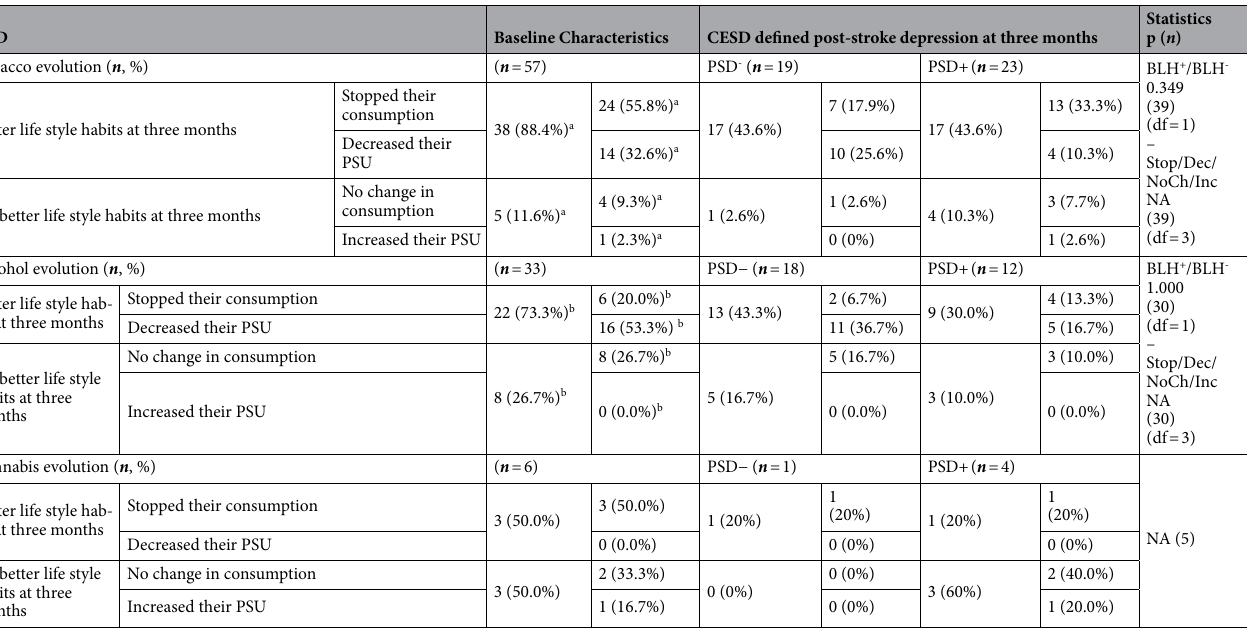
Table 3. Evolution in substance use by substance use disorder group and proportion of PSD in each group. SUD Substance use disorder, BLH + Better life style habits at three months, BLH − No better life style habits at three months a ( n = 43), b ( n =